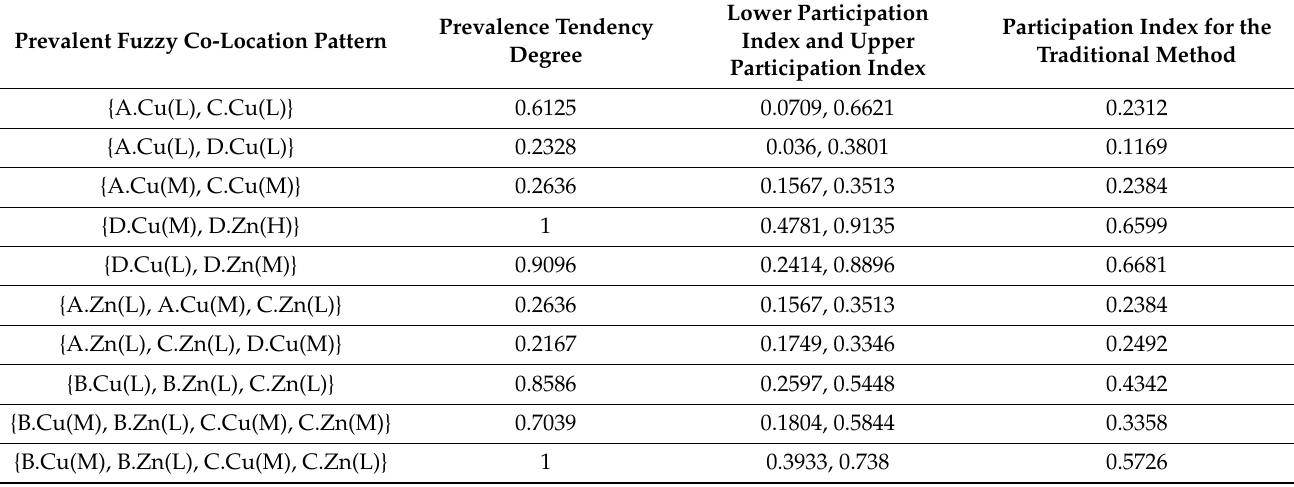
Table 6. Part of the mining results for real dataset 1.